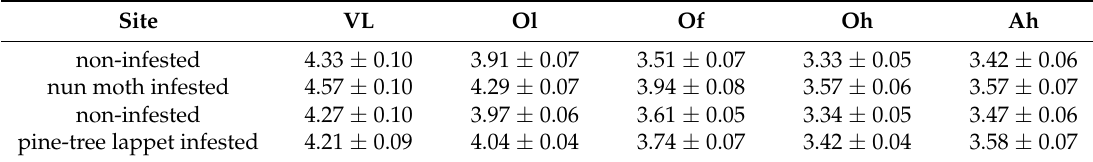
Table A1. Mean [ ± standard error] of pH (soil:H 2 O ratio 1:10 for the organic layers and 1:2.5 for the Ah) values of the vegetation layer, organic layer and the mineral soil of nun moth ( Lymantria monacha L.) and pine tree lappet ( Dendrolimus pini L.) infested and non-infested Scots pine ( Pinus sylvestris L.) forest sites. VL = vegetation layer, Ol = litter organic, Of = fibric organic, Oh = humic organic, Ah = humic mineral.